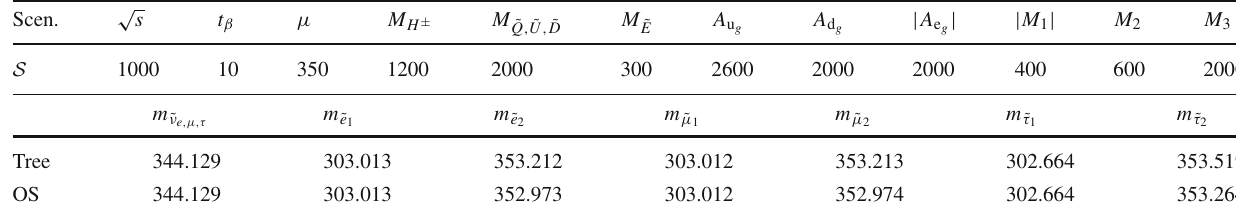
Table 1 MSSM default parameters for the numerical investigation; all parameters (except of t β ) are in GeV. The values for the trilinear sfermion Higgs couplings, A f are chosen to be real (except for A e which can be complex) and such that charge- and/or color-breaking minima are avoided [85–91]. It should be noted that we chose com-